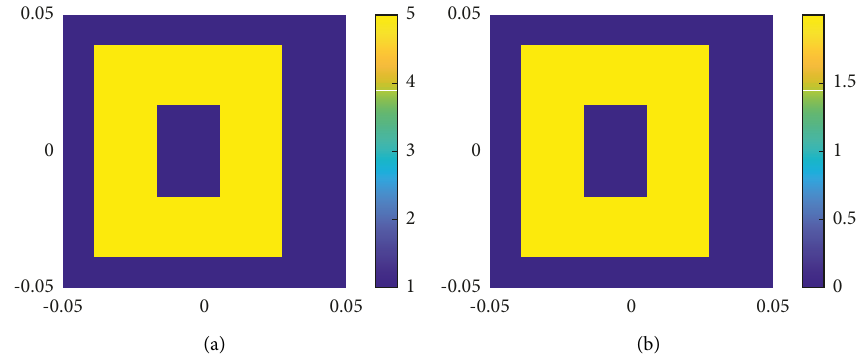
Figure 18: Inversion results obtained by proposed algorithm. (a) Real part. (b) Imaginary part.